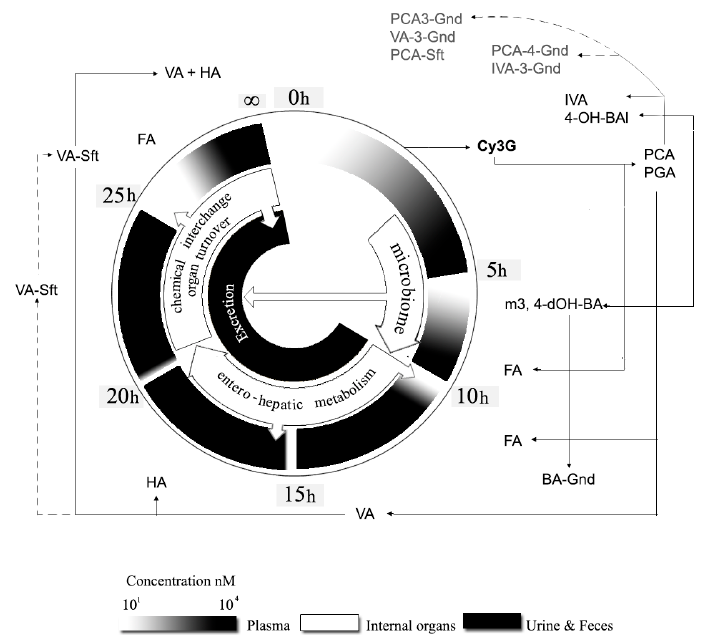
Figure 4. Time-course bioavailability of Cy3G and its main metabolites. Note: The absorption and biotransformation of cyanidin-3- O -glucoside ( Cy3G ) into derivates and metabolites are depicted clockwise in this figure and explained in detail within the text. See abbreviations section for the meaning of terms.